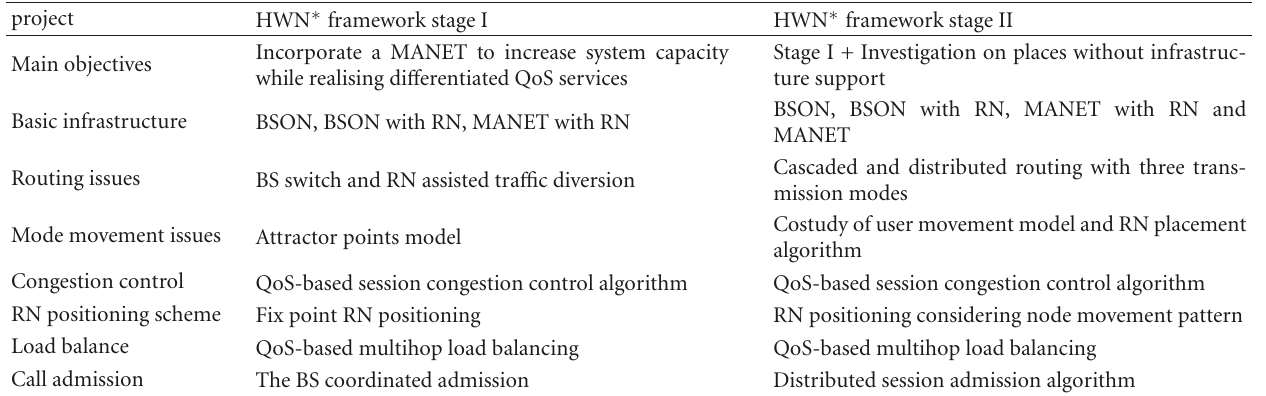
Table 1: Research improvement of HWN ∗ framework stage